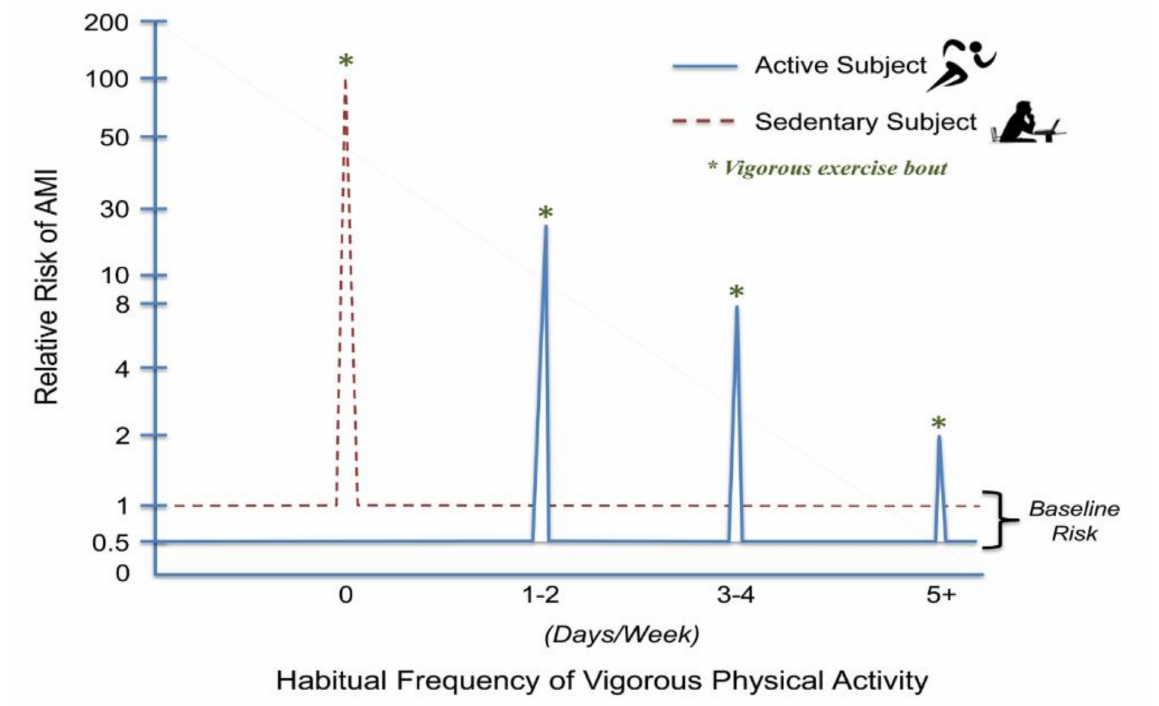
Figure 4. The relative risk for an acute myocardial infarction (AMI) is presented at rest (baseline) and during vigorous activity (days/week). No regular vigorous physical activity elevates the risk of an isolated, unaccustomed bout of vigorous exercise by ≥ 100-fold. Performing one to two days of weekly vigorous physical activity markedly lowers AMI risk during vigorous physical exertion. More frequent performance of vigorous physical activity further lowers exercise related AMI risk, although the relationship is not linear [74,75]. Vigorous exercise is delineated by the asterisks (*). Reprinted with permission from the American Heart